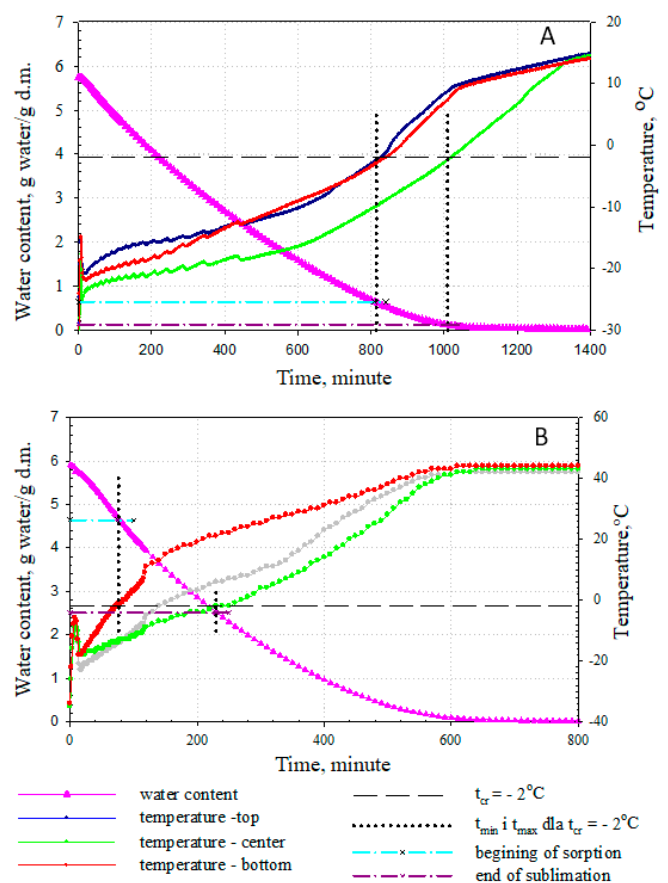
Figure 3. Kinetics of changes in the water content and material temperature measured along the slice axis and at its upper and lower surface during the freeze-drying of 1 cm-thick apple slices. The process was carried out at a pressure of 63 Pa and different shelf temperatures (T): ( A )—T = 10 °C; ( B )—T = 50 °C: adopted from [19].